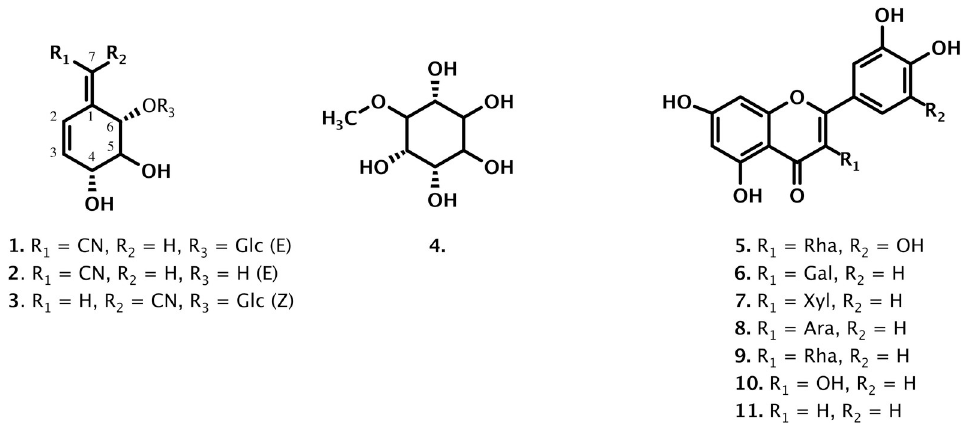
Fig 3. Isolated compounds from the hydroalcoholic leaves extract of Bauhinia holophylla .